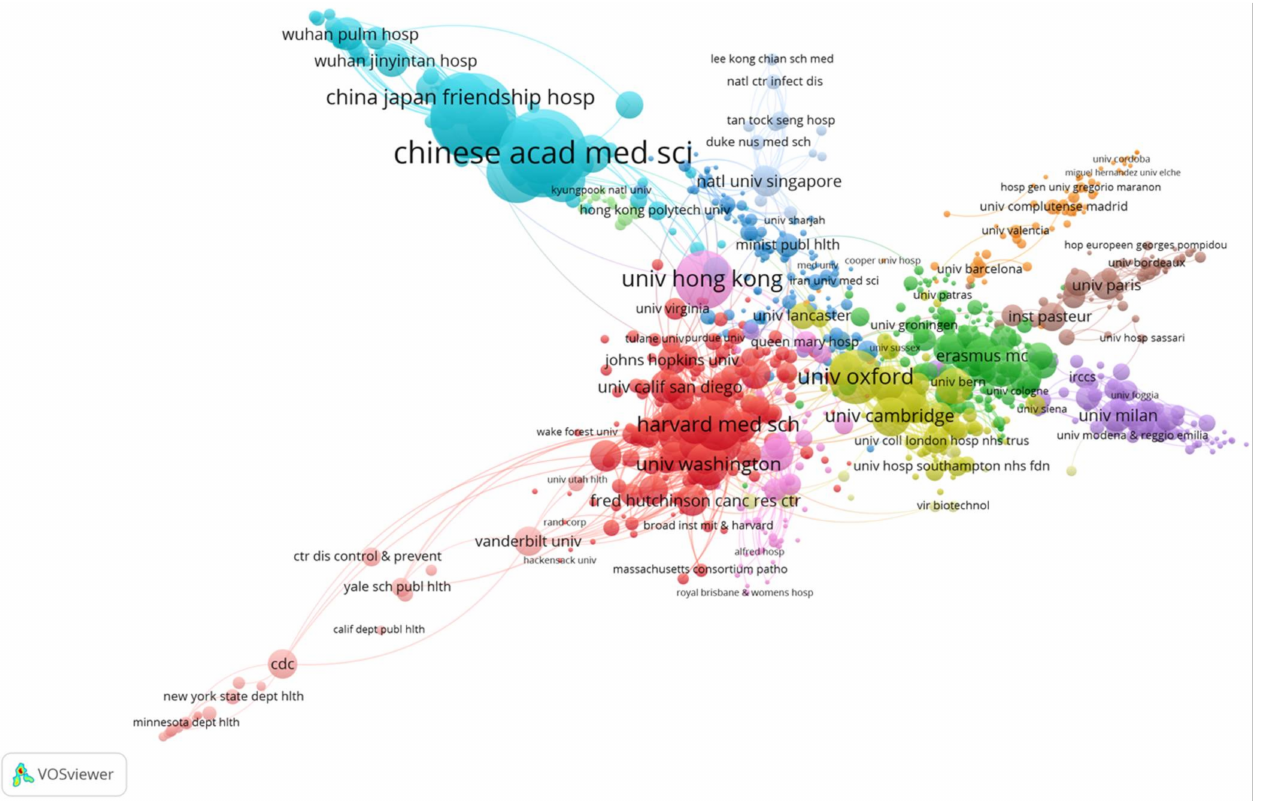
Figure 2. Most influential organisations in the body of publications on health communication and